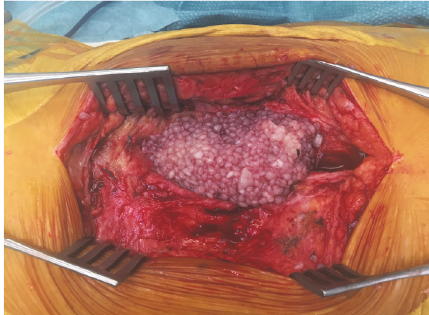
Figure 3: A per-operative view of the rice-like body cyst. The rice- like body cyst discovered in the per-operative setting. The rice-like bodies are seen bathing in a clear fluid. An encapsulated cyst.